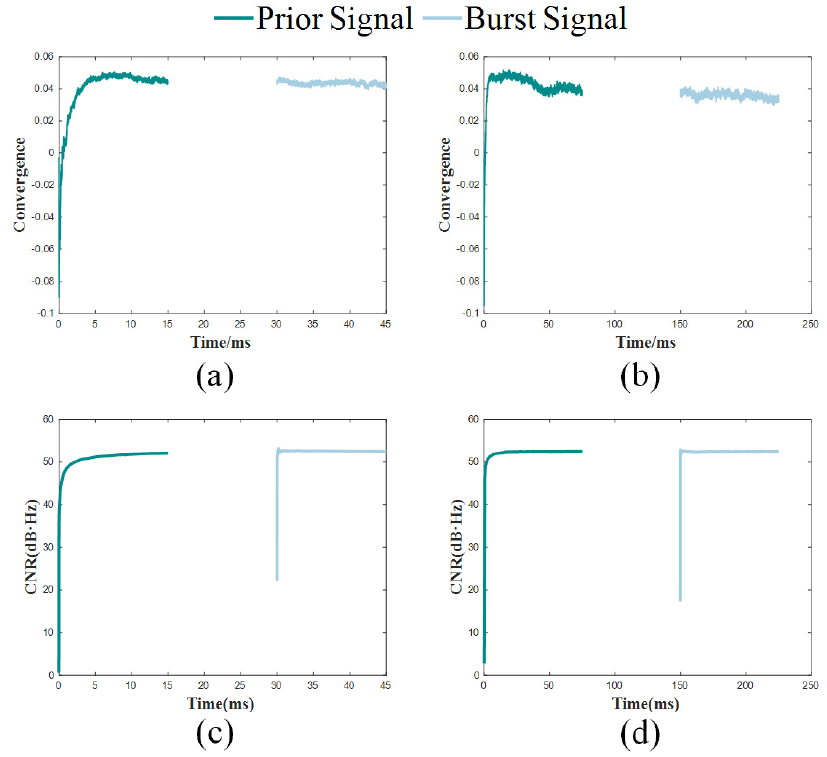
Figure 14. Performance comparison under scenarios with different signal reception intervals. ( a ) The convergence performance, the reception interval is 15 ms. ( b ) The convergence performance, the reception interval is 75 ms. ( c ) The interference suppression performance, the reception inter- val is 15 ms. ( d ) The interference suppression performance, the reception interval is 75